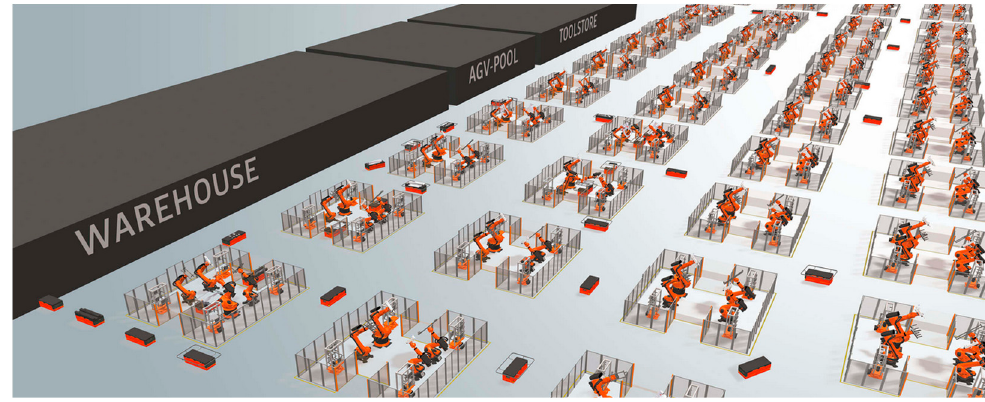
Figure 19. Industry 4.0—matrix production by KUKA [2].